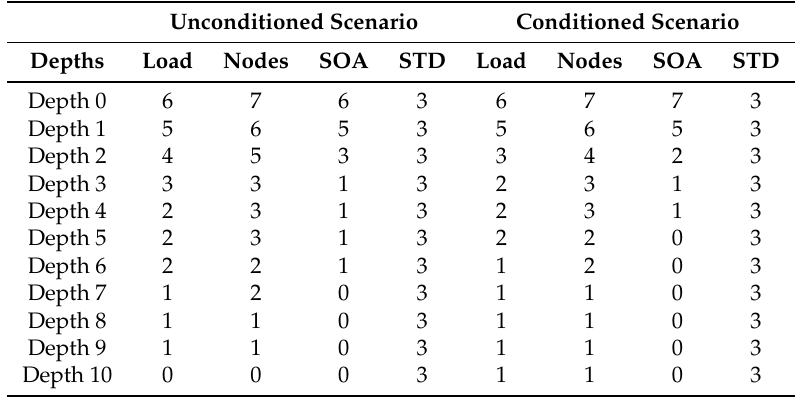
Table 7. Average Superframe Order (SO) parameter values for cluster-heads (per